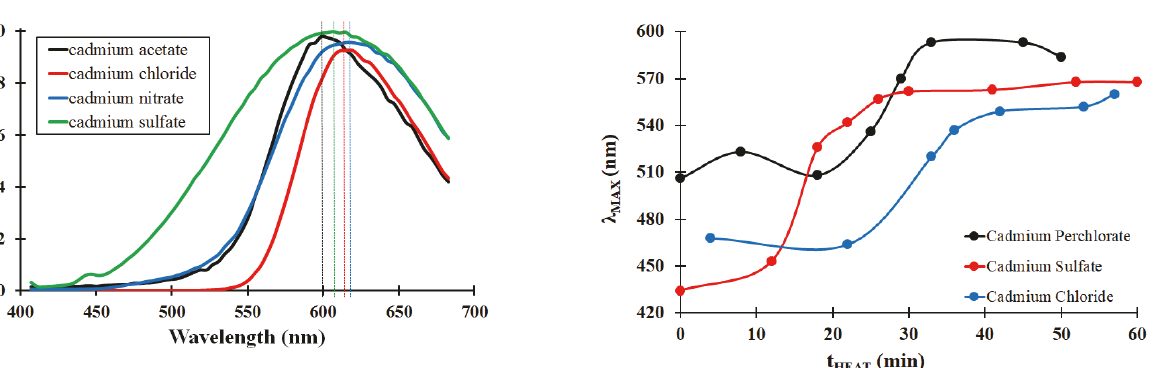
Figure 2: Effect of heating time on fluorescence emission properties of cysteine-modified CdSe QDs using different metal